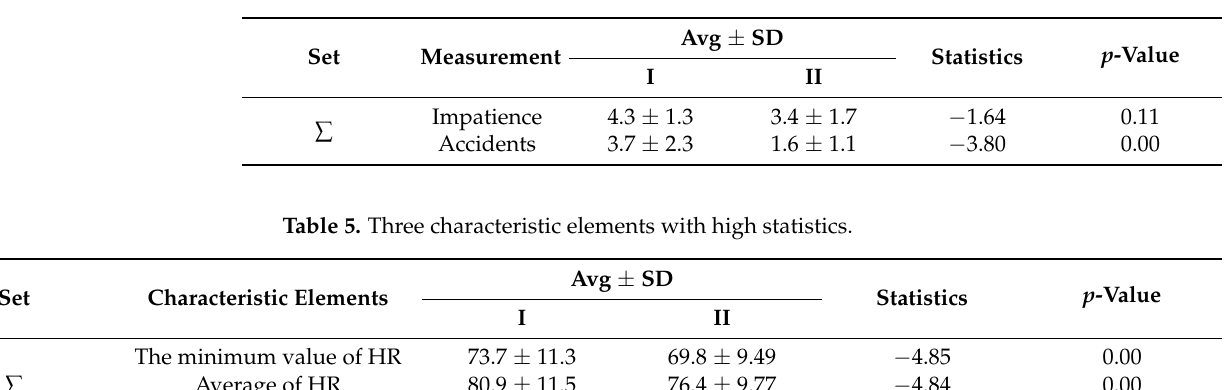
Table 4. Subjective impatience and number of accidents in young and old drivers in Experiment I and Experiment II.